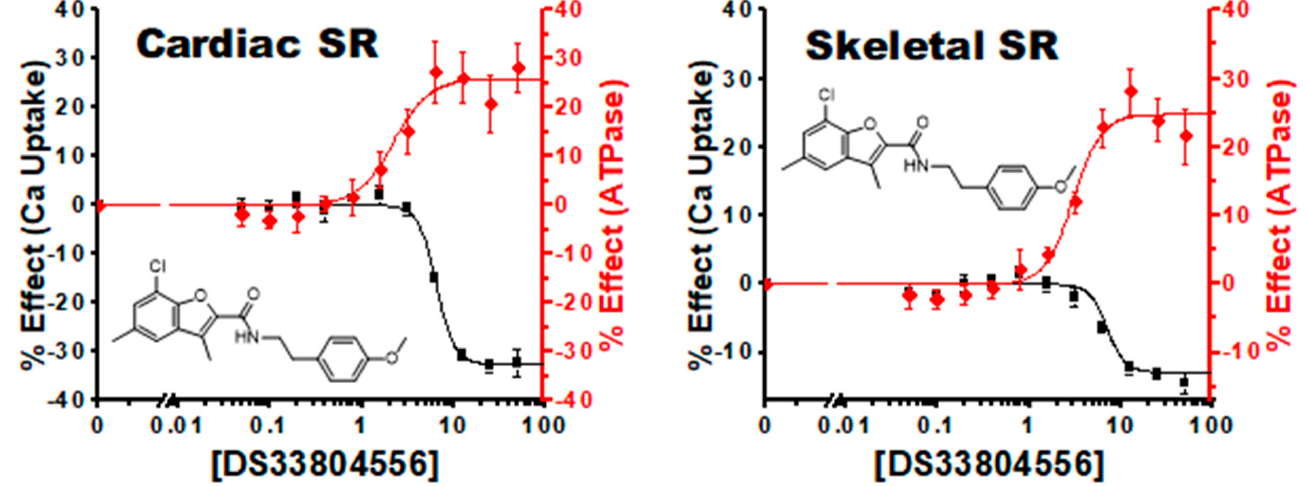
Figure 6. Uncoupling Compounds: Concentration response curve of compound #16 (DS33804556) in cardiac SR and skeletal SR show an inhibition of Ca2+ uptake activity despite a substantial increase in ATPase activity.